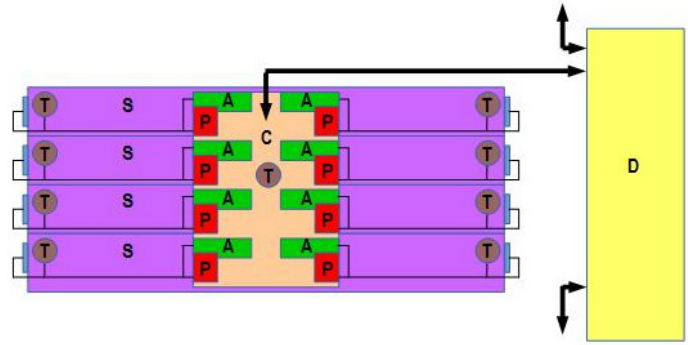
Figure 8. Conceptual design of the MCORD detector readout section. Legend: S (violet) – plastic scintillator, (blue-both ends of scintillators) – SiPM, P (red) – power supply with the temperature com- pensation circuit, T (brown) – temperature sensor, A (green) – amplifier, D (yellow) – MicroTCA digital system, C (orange) – Analog Front End